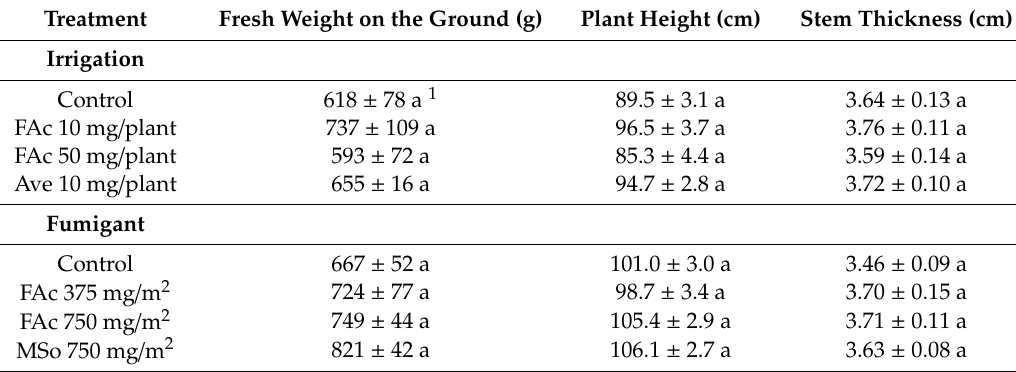
Table 4. Growth e ff ect of FAc on tomato plants in the field experiments